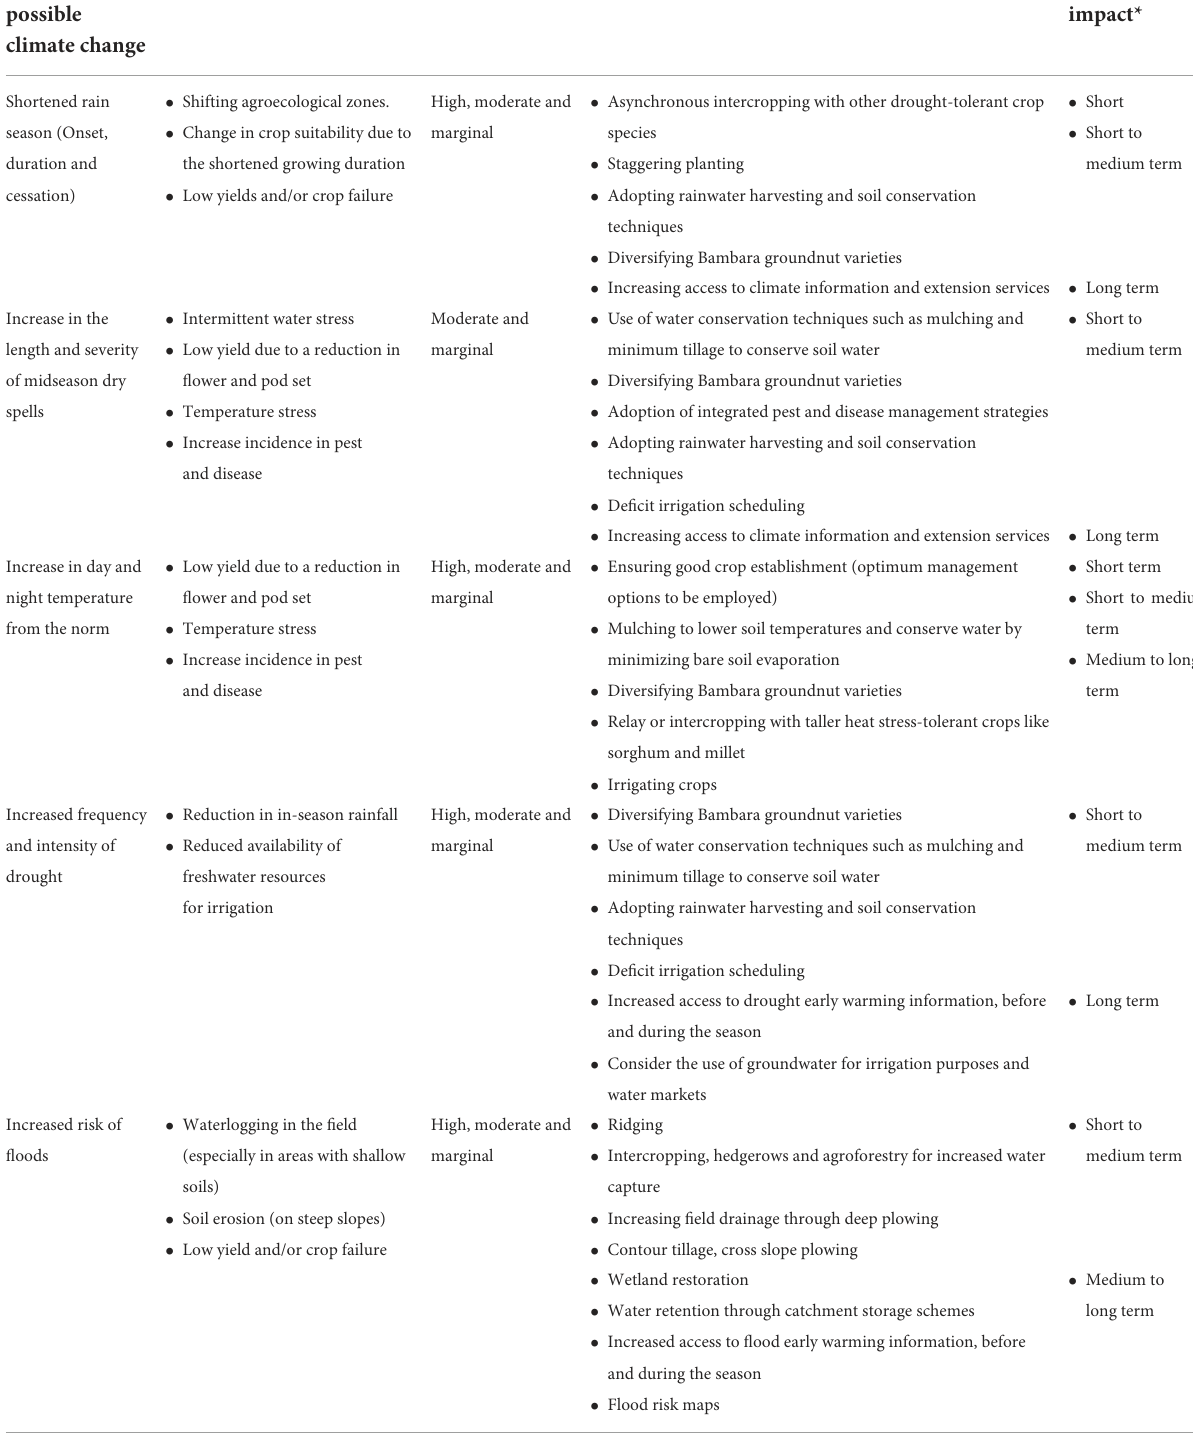
TABLE 5 Assessing the impacts of climate change for Bambara groundnut suitability [Adapted from Mpandeli et al. (2019) and Chimonyo et al. (2020)]. Observed/